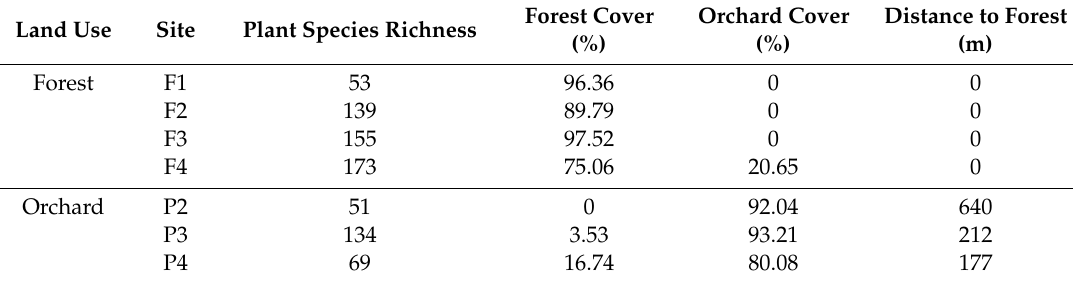
Table 1. Landscape characteristics of study